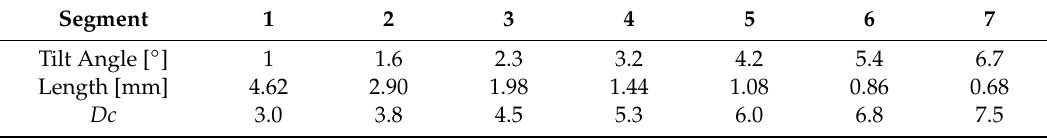
Figure 2. Illustration of the segmented array. The sketch is not to scale and in the real device, there is no gap between segments. The expected particle sizes in each outlet are as follows. Out 1: 0 µm (non-displaced) to 3 µm, Out 2: 3.8–5.3 µm, Out 3: > 6.0 µm. Table 1. Variables within each segment to allow 80 µ m displacement, tilt angle, length of each segment and resulting critical particle size for